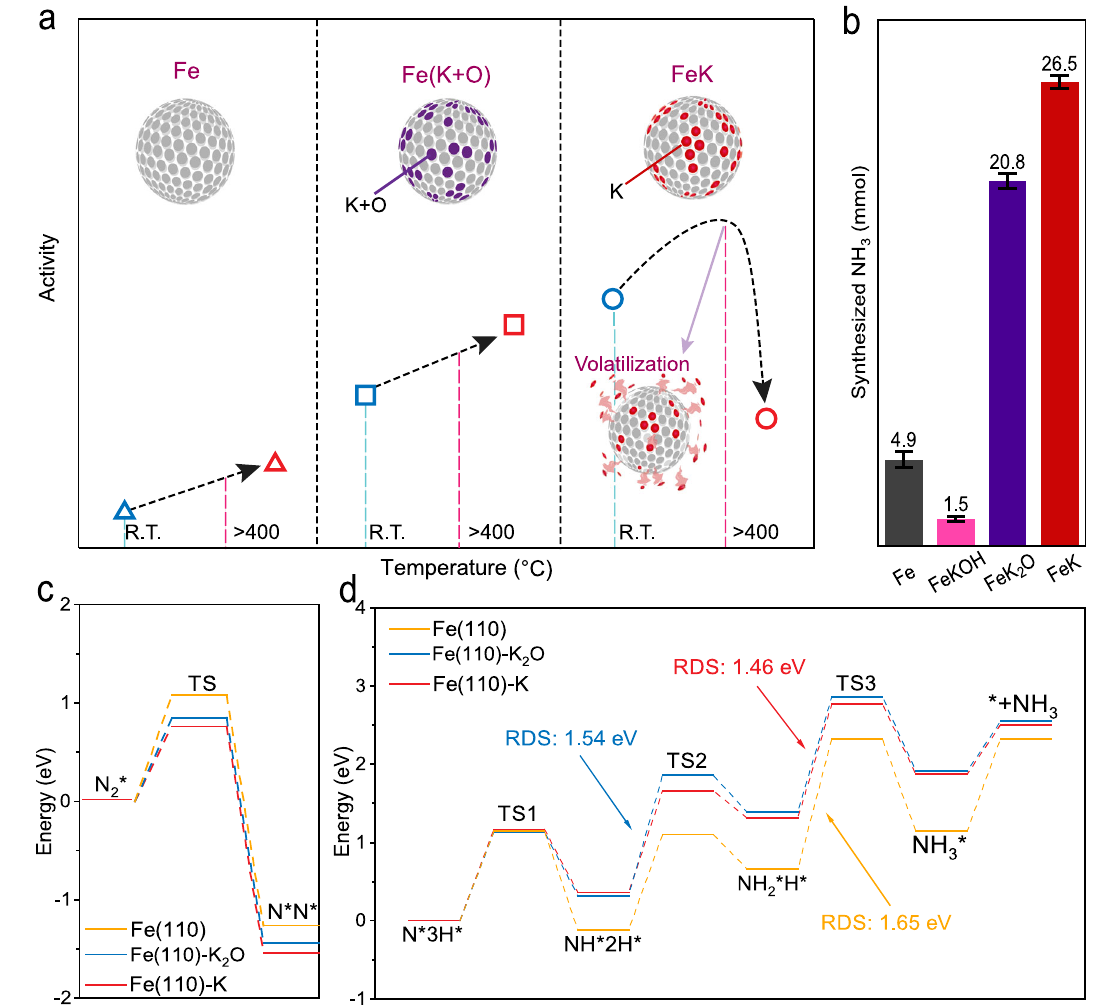
Fig. 1 | Comparison of Fe catalytic activity with different K promotors. a SchematicofFecatalyticactivitywithdifferentpromotorsdependingonreaction temperature.PureKandoxygenatedKderivatives(K 2 OandKOH,bothdenoted as K+O) are used as K promotors for NH 3 synthesis. At a temperature above 400°C, theactivityofKonFe(FeK)isdiminishedbytheKdesorptionfromthesurfaceofFe catalyst. Therefore, oxygenated K derivatives on Fe [Fe(K+O)s] show better per- formanceabove 400°C.However,atatemperaturebelow400°C,theKcanstably stick to the surface of FeK, showing much higher activity than Fe(K+O)s. Color code in the cartoon: gray, dark red, and purple circles are Fe, K+O, and K,